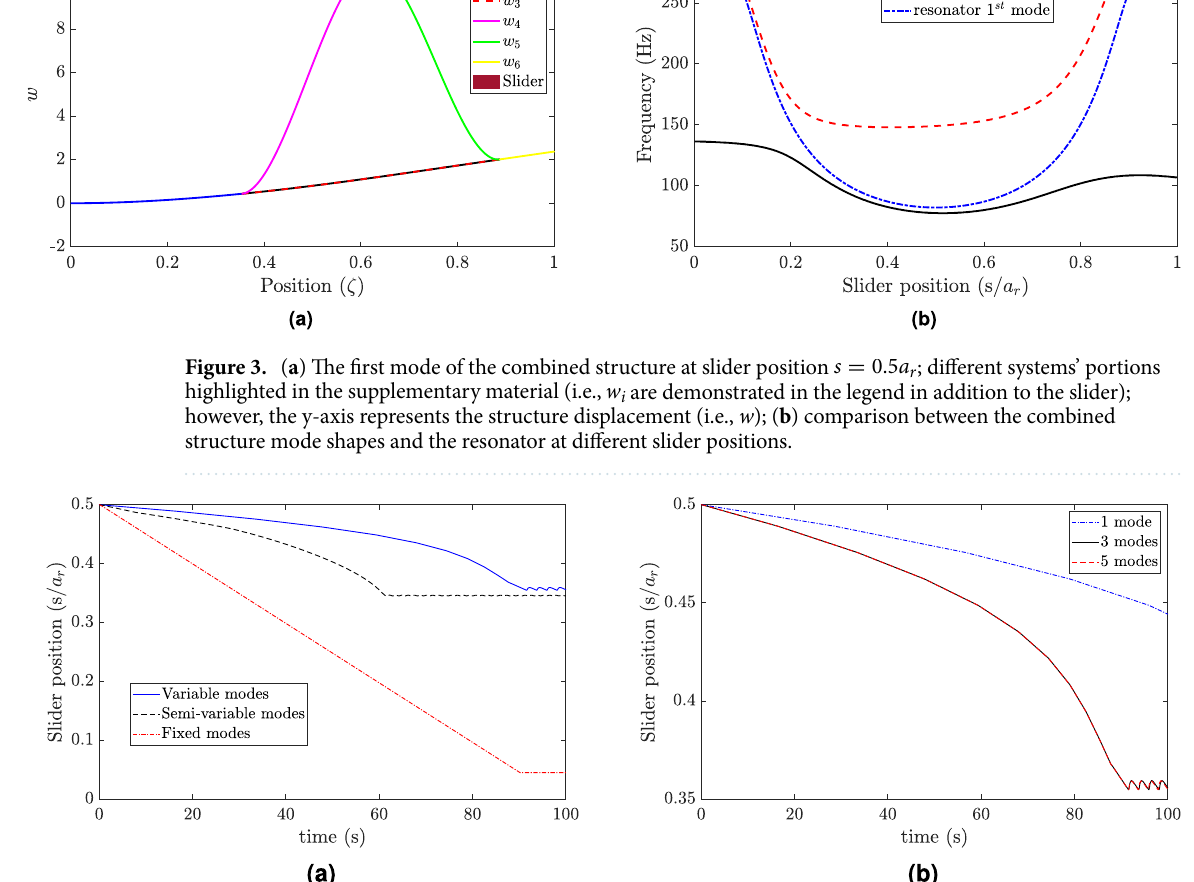
Figure 4. ( a ) Comparison of equilibrium position of slider using different algorithms; Variable modes: updating the mode shapes at every time step, semi-variable modes: updating the modes at a larger time step, fixed modes: using assumed fixed mode shapes. Other parameters for simulation are s 0 = 0.5 / a r , f = 90 Hz, w 0 = 0.1 g , n = 3 ; ( b ) The effect of the number of considered mode shapes in the simulation on the results. Other parameters for simulation are s 0 = 0.5 / a r , f = 90 Hz, w 0 = 0.1 g (note that the response curve of three- mode case (solid black) coincide with the response curve of the five-mode case (dashed